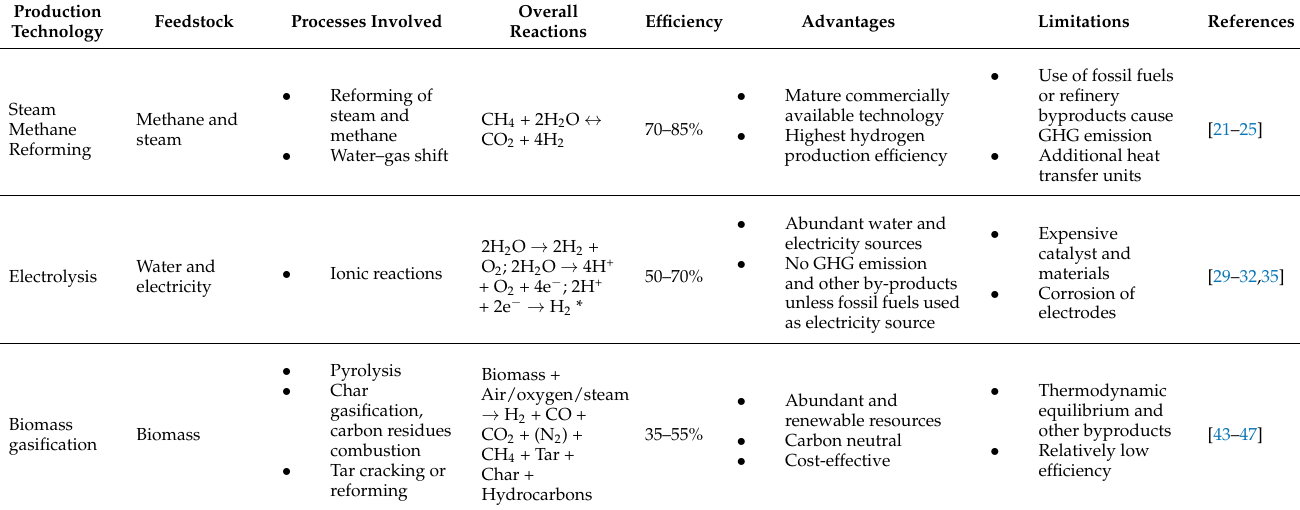
Table 1. Comparisons of hydrogen production technologies by steam methane reforming, electrolysis and biomass